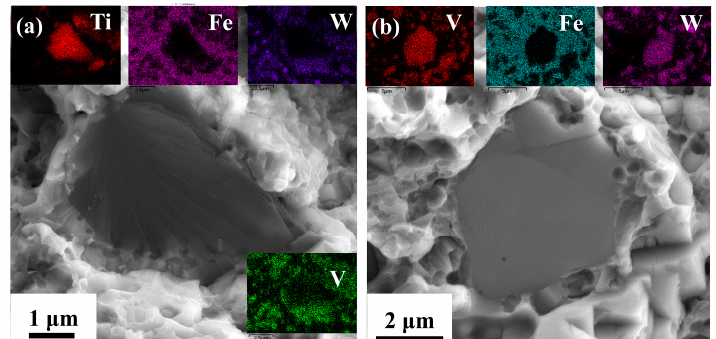
Figure 9. The effect of the volume fraction and type of additive MC-type carbides on the 3-point bending strength of designed MMCs. ( a ) Histograms of 3-point bending strength vs. volume frac- tion and type of carbides; ( b ) Curves of 3-point bending strength vs. MC-type carbides addition.